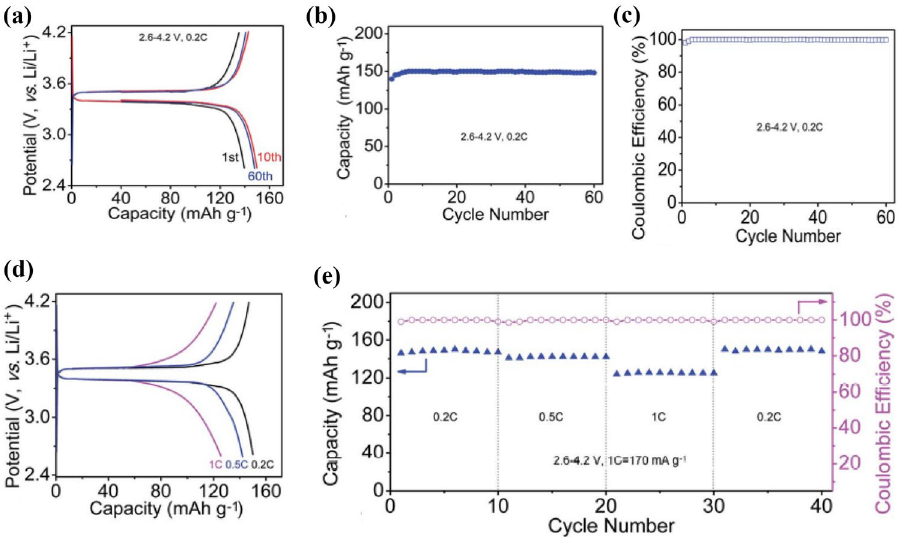
Fig. 8 Electrochemical performance of Li/ionogel electrolyte/LiFePO cells at 20 4 C: a first, tenth and sixty cycles, b discharge capacity and ( c ) Coulombic efficiency dur- ing cycling at 0.2C. d charge/ discharge voltage profiles at current densities between 0.2C and 1C, and e capacity and Coulombic efficiency during cycling at current densities between 0.2C and 1C